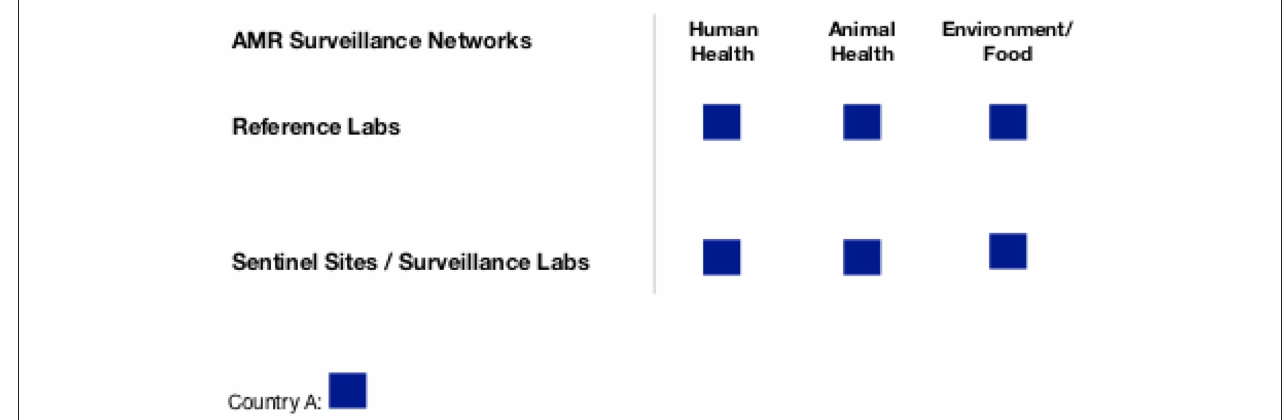
FIGURE 2 | Sites selected for fieldwork in Country